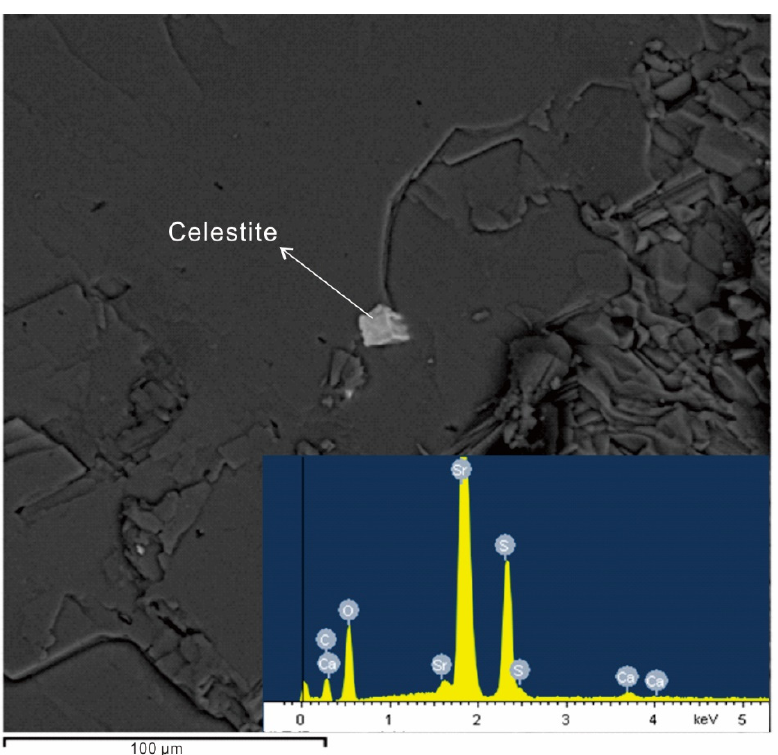
Figure 9. SEM image of gypsum sample from Rigei showing the occurrence of celestite.